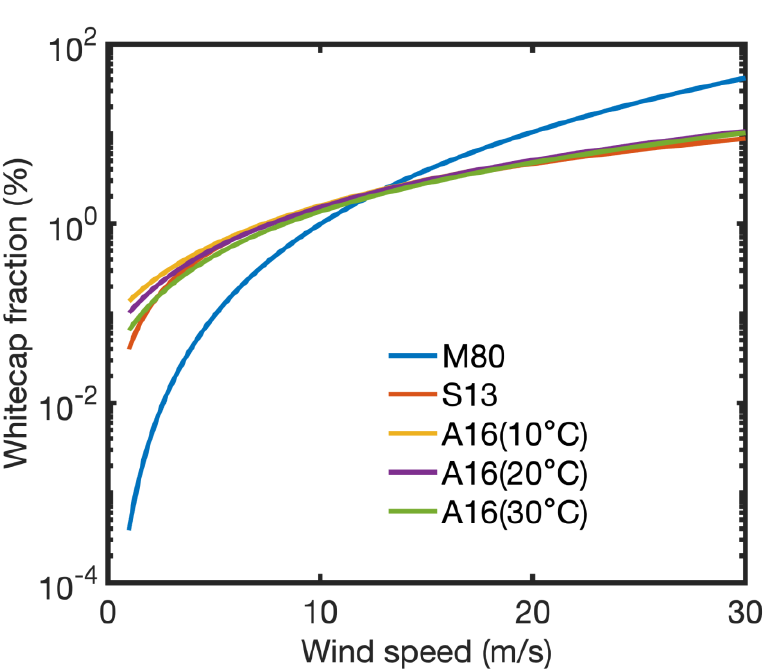
Figure 3. Different parameterizations for whitecap fraction relationships, where the sea surface temperatures in A16 are 10, 20, and 30 °C, respectively.